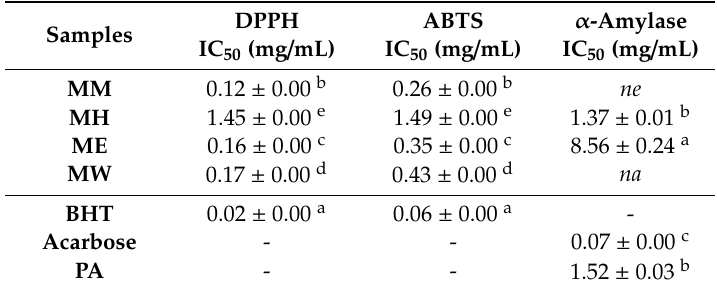
Table 2. Antioxidant and anti- α -amylase activities of C. indica fruit extracts.